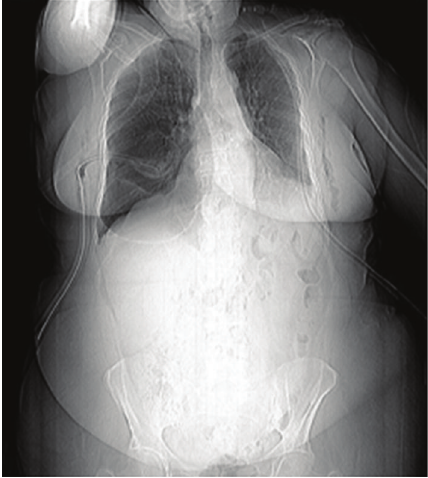
Figure 17: A CT Scanogram showing bilateral chest drains the right drain is inappropriately placed in a right basal